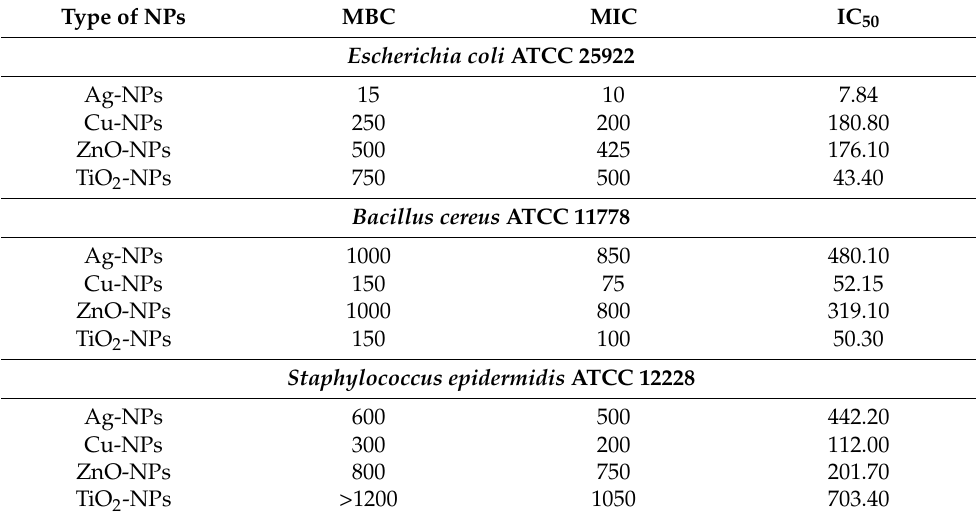
Table 1. The values of MBC, MIC and IC 50 (mg L − 1 ) of NPs against E. coli , B. cereus and S. epidermidis